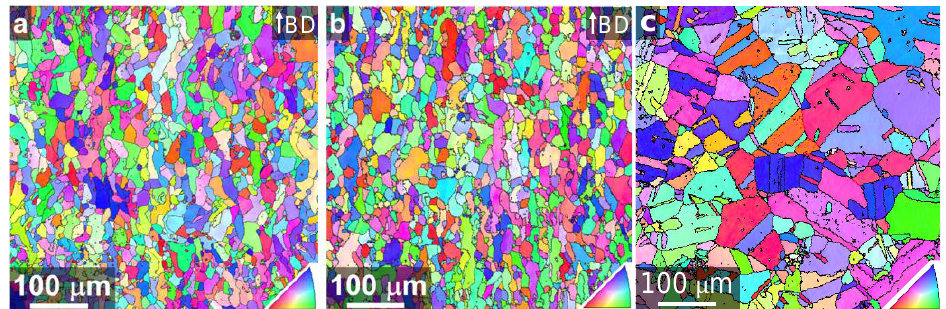
Figure 2. EBSD orientation maps showing the microstructure after PBF-EB processing with parameter sets B33 ( a ) and B50 ( b ). Building direction is vertical. ( c ) EBSD orientation map of HP reference material modified after [16]. High angle grain boundaries are marked black.